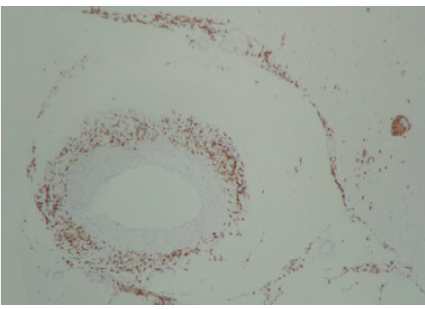
Figure 3: Infiltration of the blood vessel wall by polyclonal T lymphocytes. (Immunohistochemical for CD3 marker.)